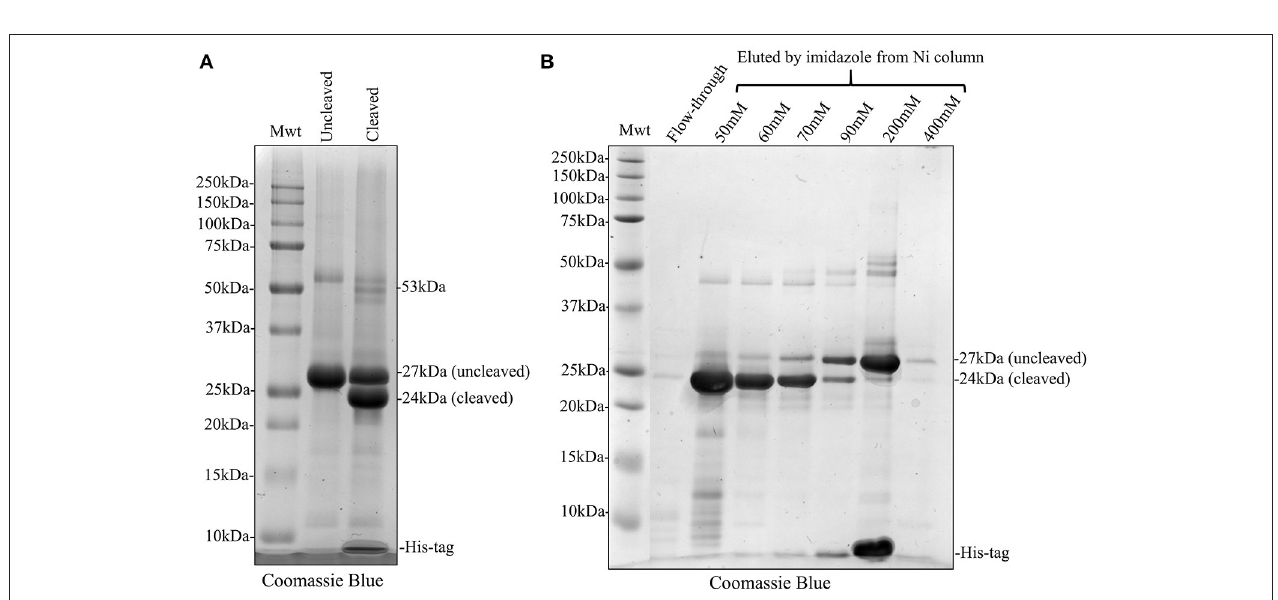
FIGURE 5 | Coomassie Blue stained SDS PAGE showing His-tag cleavage of recombinant amelogenin and second round of nickel column purification using stepped elution gradient to optimize purification of cleaved amelogenin from the cleavage reaction mixture. (A) Cleavage of His-tagged 27 kDa recombinant (Uncleaved) with HRV3C protease was not 100% efficient. The cleaved reaction mixture (Cleaved) contained 24 kDa cleaved and 27 kDa uncleaved recombinant. (B) The cleaved recombinant was retained on the nickel column despite lacking a His-tag and did not appear in the column flow-through (Flow-through). Subsequent elution with an increasing stepped imidazole gradient eluted the cleaved recombinant at imidazole concentrations of 50 mM and above but some uncleaved recombinant amelogenin and lower molecular weight contaminants were co-eluted. The bulk of uncleaved recombinant amelogenin and free His-tags were eluted by 200 mM imidazole. Elution using 60 mM imidazole was selected since compared to 50 mM this would increase the yield of cleaved recombinant without overly increasing the elution of uncleaved recombinant as a contaminant.